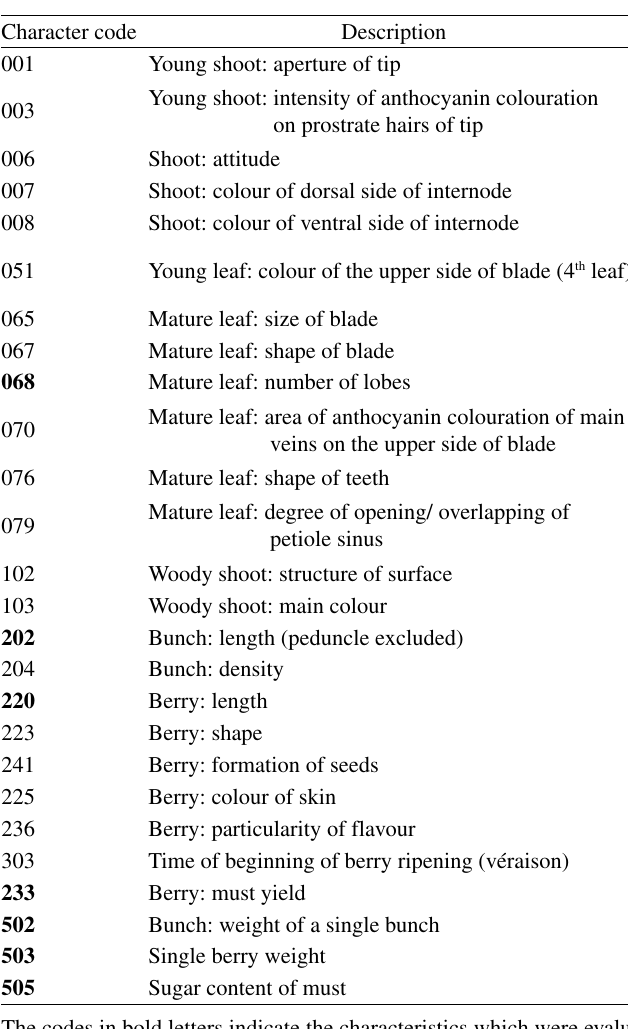
(Table 3) were determined for each leaf using image-analy- sis software (UTHSCSA Image Tool Program 3.0).